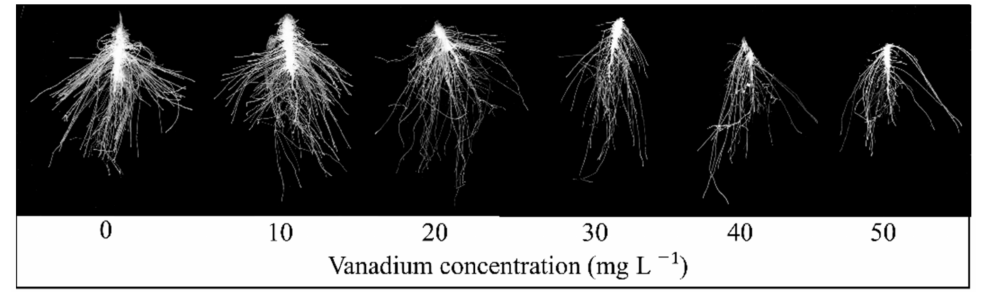
Figure 4. Root architecture system of pepper seedlings grown under V toxicity.